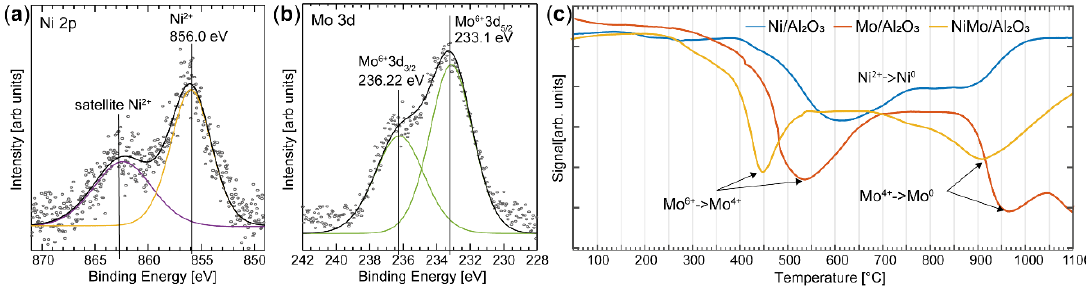
Figure 6. Chemical analysis of the NiMo / δ -Al 2 O 3 sample was performed using XPS and H 2 -TPR. ( a ) XPS spectra of the Ni 2p 3 / 2 and ( b ) Mo 3d regions. Fitting the spectra indicates a strong interaction between Ni and Mo. ( c ) H 2 -TPR spectra from the Mo / δ -Al 2 O 3 , Ni / δ -Al 2 O 3 , and NiMo / δ -Al 2 O 3 catalysts. The results show that Ni promotes the reduction of the Mo oxide.